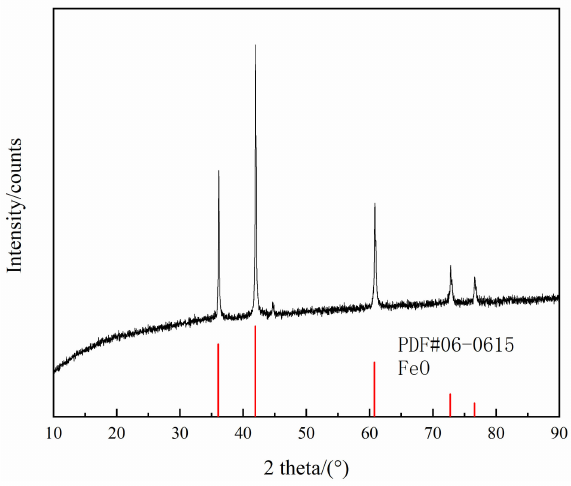
Figure 1. XRD results for FeO powder.